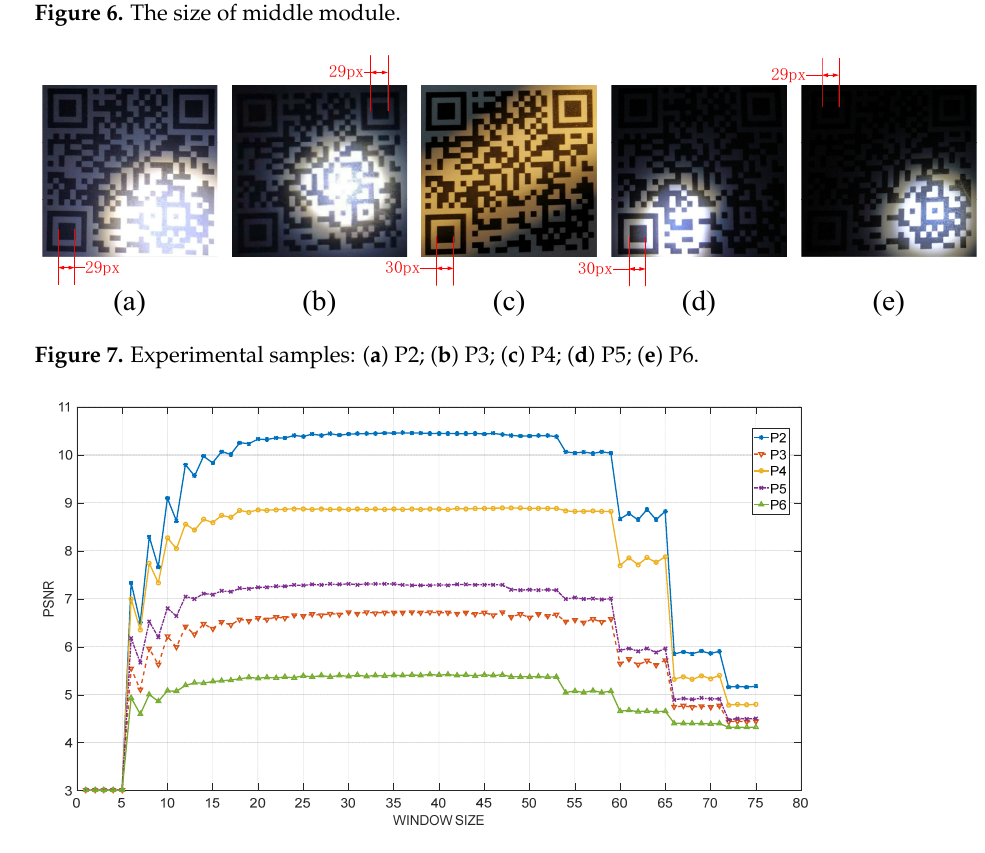
Figure 8. PSNR value curves of five 300 × 300 samples after processing.